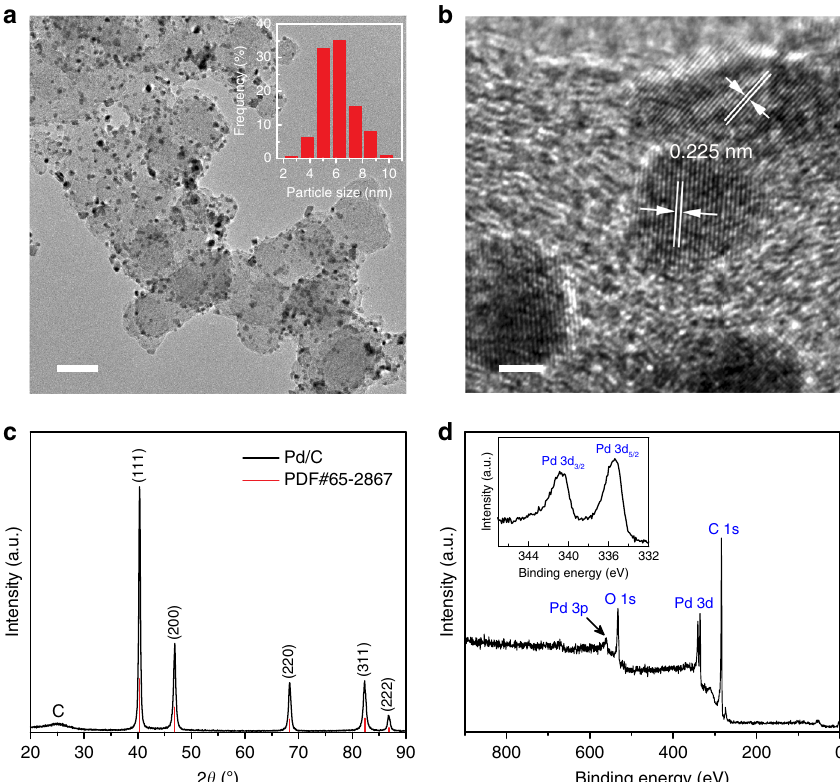
Fig. 1 Structural and compositional characterizations of the Pd/C catalyst. a TEM and b high-resolution TEM images of the Pd/C catalyst. Inset a : particle size distribution. Scale bars, a 50 nm; b 2 nm. c XRD pattern and d XPS survey spectrum of the Pd/C catalyst. Inset d : high-resolution XPS spectrum of Pd 3d